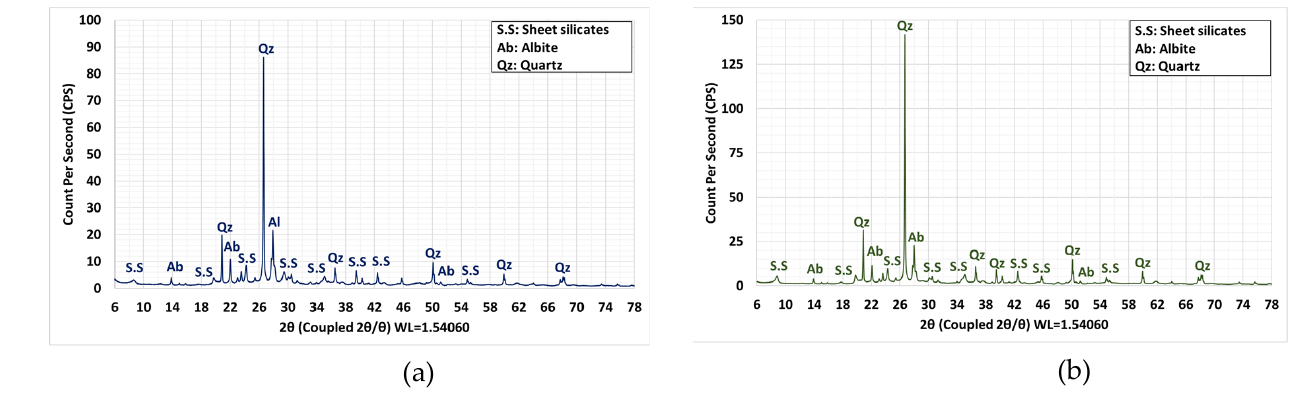
Figure 5. The whole rock XRD diffractogram of ( a ) sample Figure 3a, and ( b ) sample Figure 3b. Sheet silicates peak at 8.9°, quartz peaks at around 21° and 27°, and albite peaks at around 14° and 28° 2 θ are recognizable. Mineral name abbreviation based on Whitney and Evans, (2010) [73].